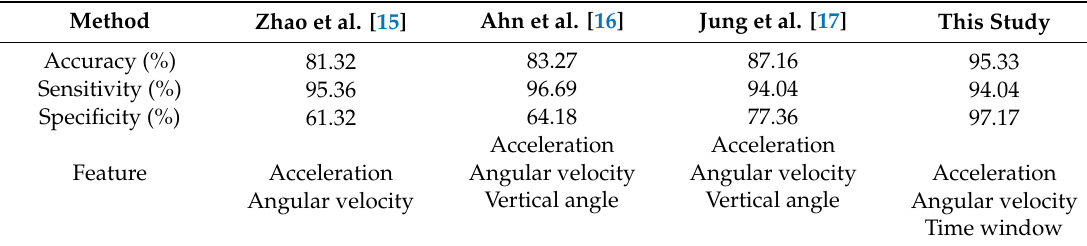
Table 1. Performance comparison with some threshold-based studies.